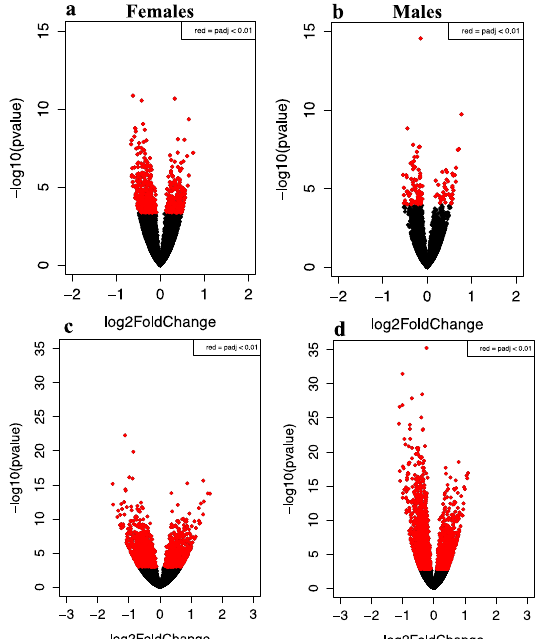
Figure 2. The effect of e-cigarettes with and without nicotine on global gene expression represented in terms of p-value and fold change ( n = 5–6 frontal cortexes per each treatment and sex group). ( a ) Gene expression data for females exposed to e-cigarettes with nicotine (female controls = black, female e-cigarette with nicotine = red). ( b ) Gene expression data for males exposed to e-cigarettes with nicotine (male controls = black, male e-cigarette with nicotine = red). ( c ) Gene expression data for females exposed to e-cigarettes without nicotine (female controls = black, female e-cigarette without nicotine = red). ( d ) Gene expression data for males exposed to e-cigarettes without nicotine (male controls = black, male e-cigarette without nicotine = red).